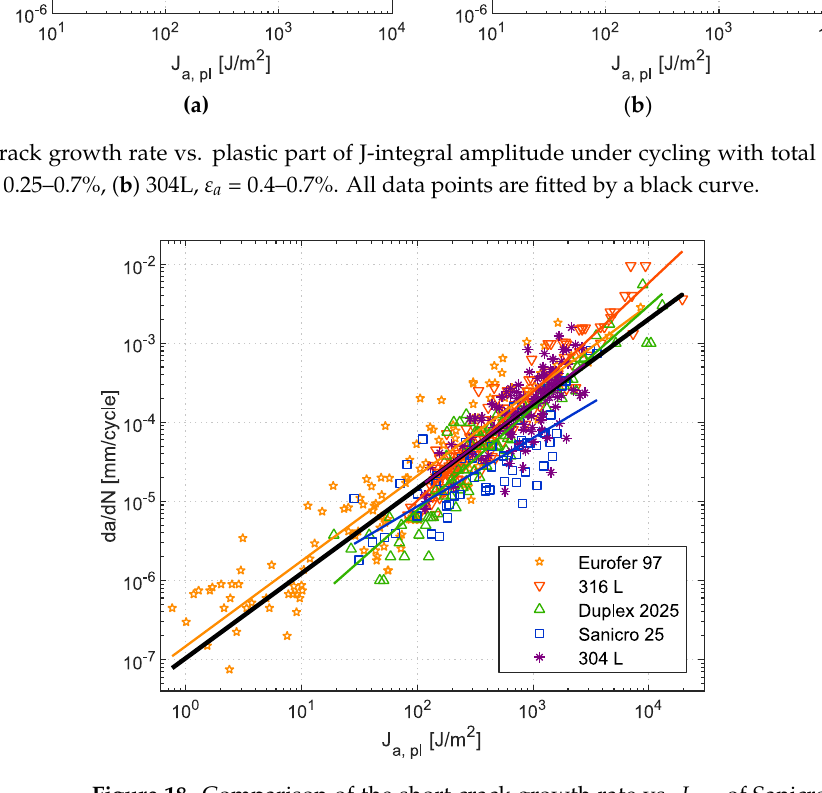
Figure 18. Comparison of the short crack growth rate vs. J a, pl of Sanicro 25 and 304L steels with previously published data of Eurofer 97 steel [28], 316L steel [16] and duplex 2025 steel [15]. Experimental data of each material include all tested amplitudes merged together. These particular datasets were fitted by the master curve.